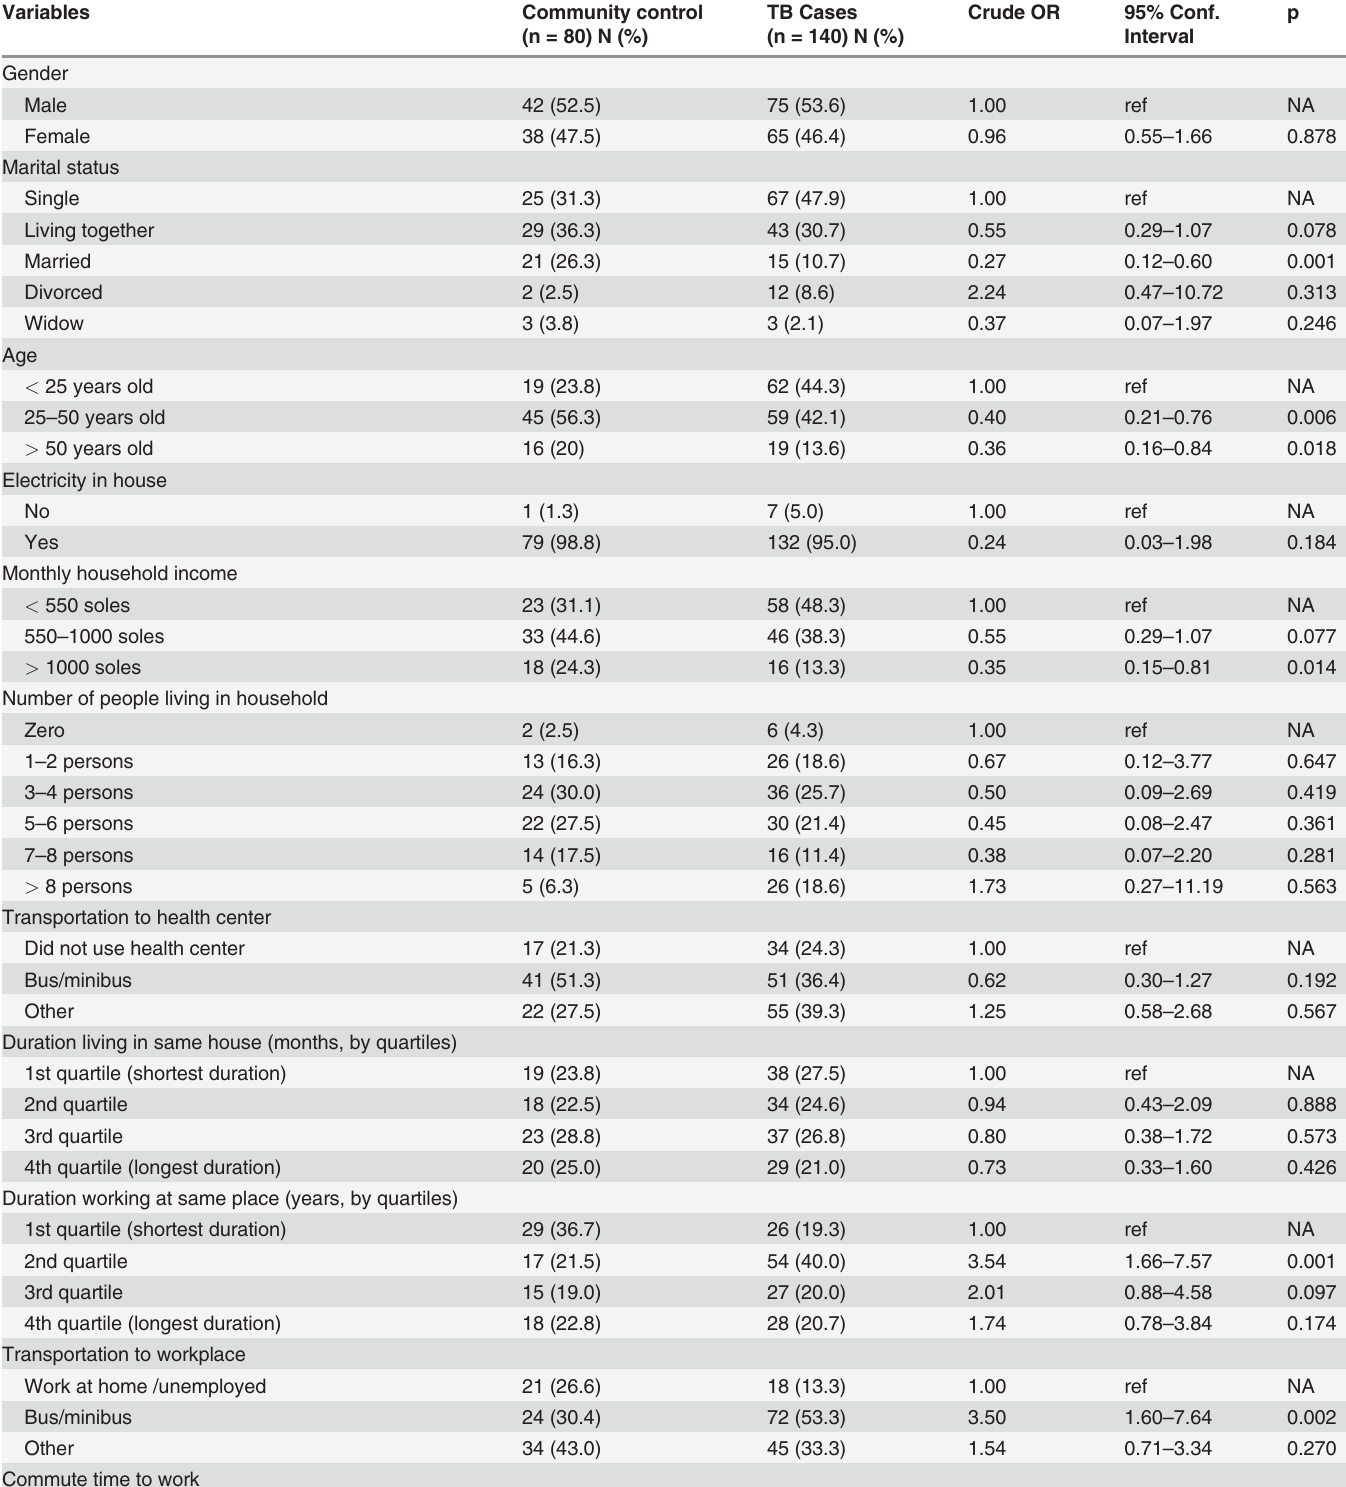
Table 1. Bivariate assessment of risk factors for